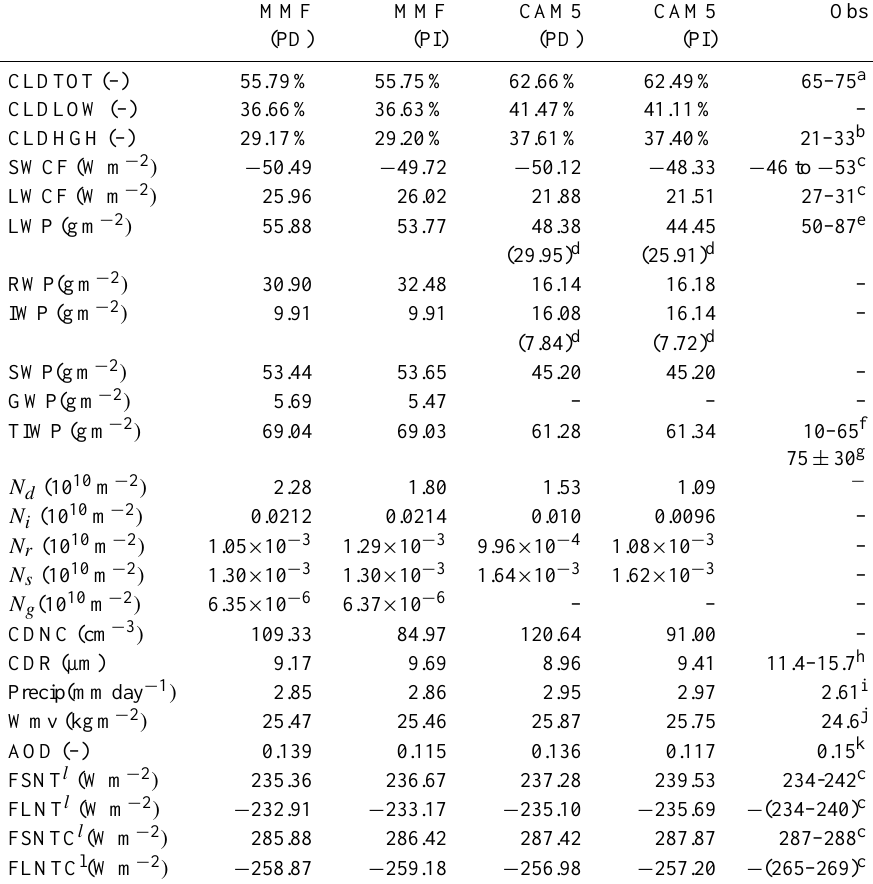
Table 1. Annual global mean cloud and radiation parameters from MMF and CAM5 simulations (PD and PI) and observations: total cloud fraction (CLDTOT), low cloud fraction (CLDLOW), high cloud fraction (CLDHGH), shortwave cloud forcing (SWCF), longwave cloud forcing (LWCF), column-integrated grid-mean hydrometeor water path (LWP, liquid water path; RWP, rain water path; IWP, ice water path; SWP, snow water path; GWP, graupel water path; TIWP, total ice water path, and TIWP=IWP+SWP+GWP), column-integrated grid-mean hydrometeor number concentrations ( N d , cloud droplets; N i , ice crystals; N r , rain droplets; N s , snow crystals; N g , graupel particles), cloud- top droplet number concentrations (CDNC) and droplet effective radius at cloud top (CDR) for low level warm clouds, precipitation rate (Precip), column-integrated water vapor (Wmv), AOD, whole-sky shortwave (FSNT) and longwave (FLNT) net radiative fluxes at the top of the atmosphere, clear-sky shortwave (FSNTC) and longwave (FLNTC) radiative fluxes at the top of the atmosphere.